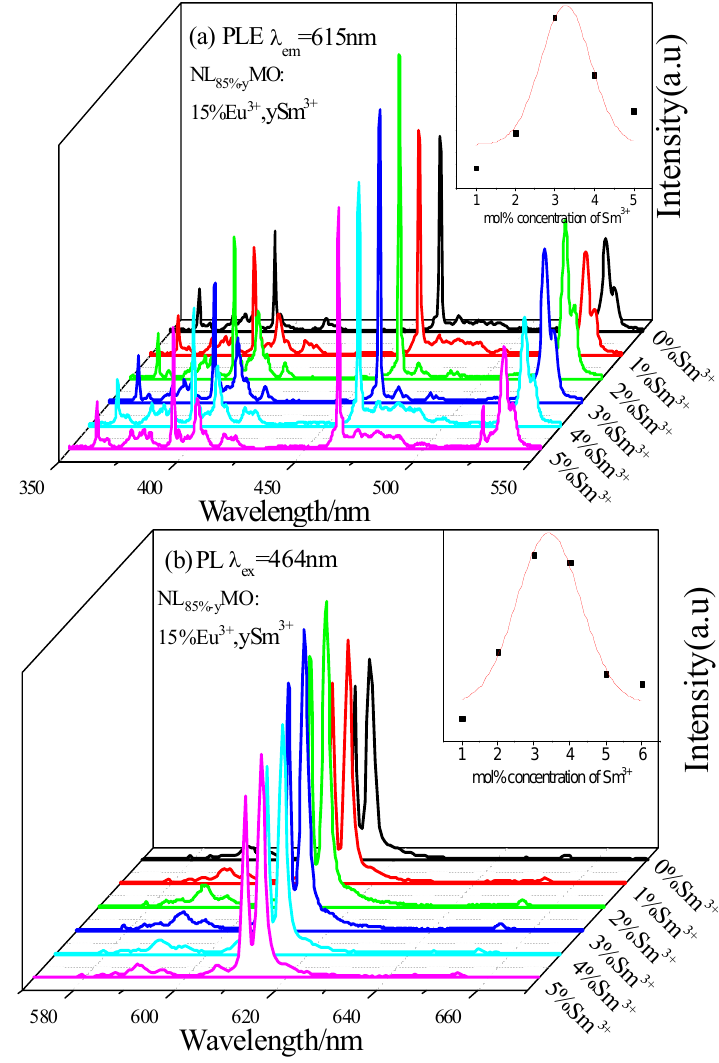
Figure 8. ( a , b ) excitation spectra ( λ em = 615 nm) and emission spectra ( λ ex = 464 nm) of NL 85% ‐ y MO:15%Eu 3+ ,ySm 3+ (y = 0, 1, 2, 3, 4 and 5%).